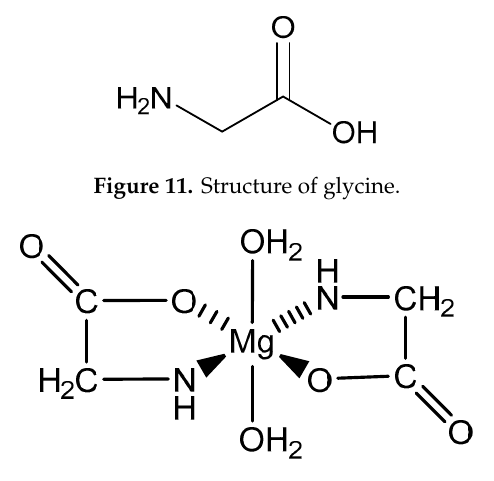
Figure 12. An illustration of the magnesium bis -glycinate dihydrate complex formed from a 1:2 magnesium–glycine stoichiometry [82,83].